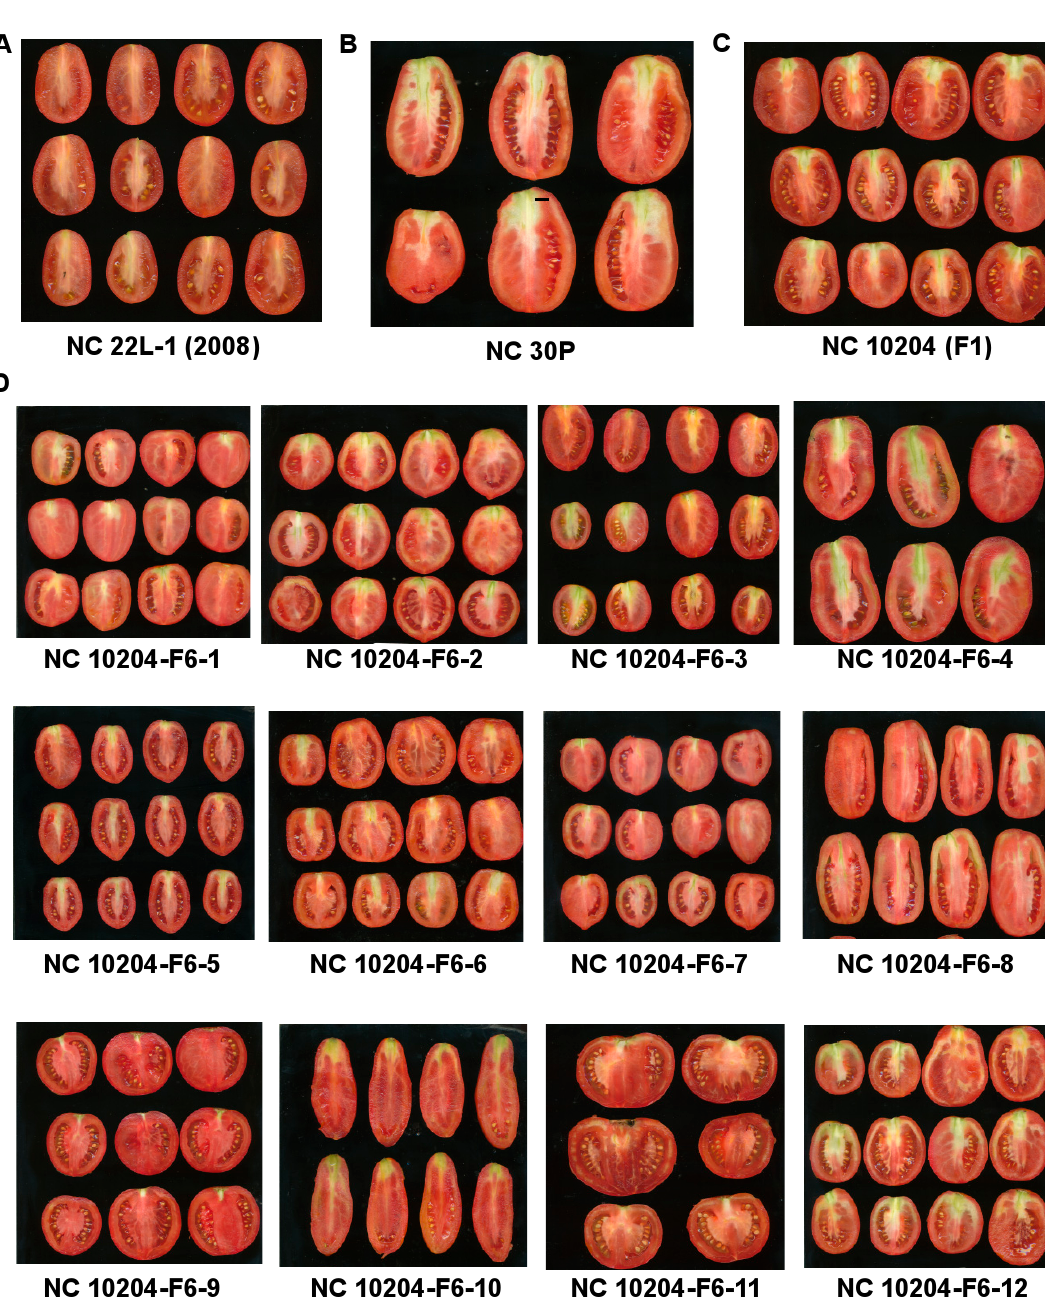
Figure 1. Fruit images cut from proximal to distal end of parental lines NC 22L-1(2008) ( A ), NC 30P ( B ), F 1 hybrid ( C ), and the phenotypic segregation in the NC 10204 population ( D ).